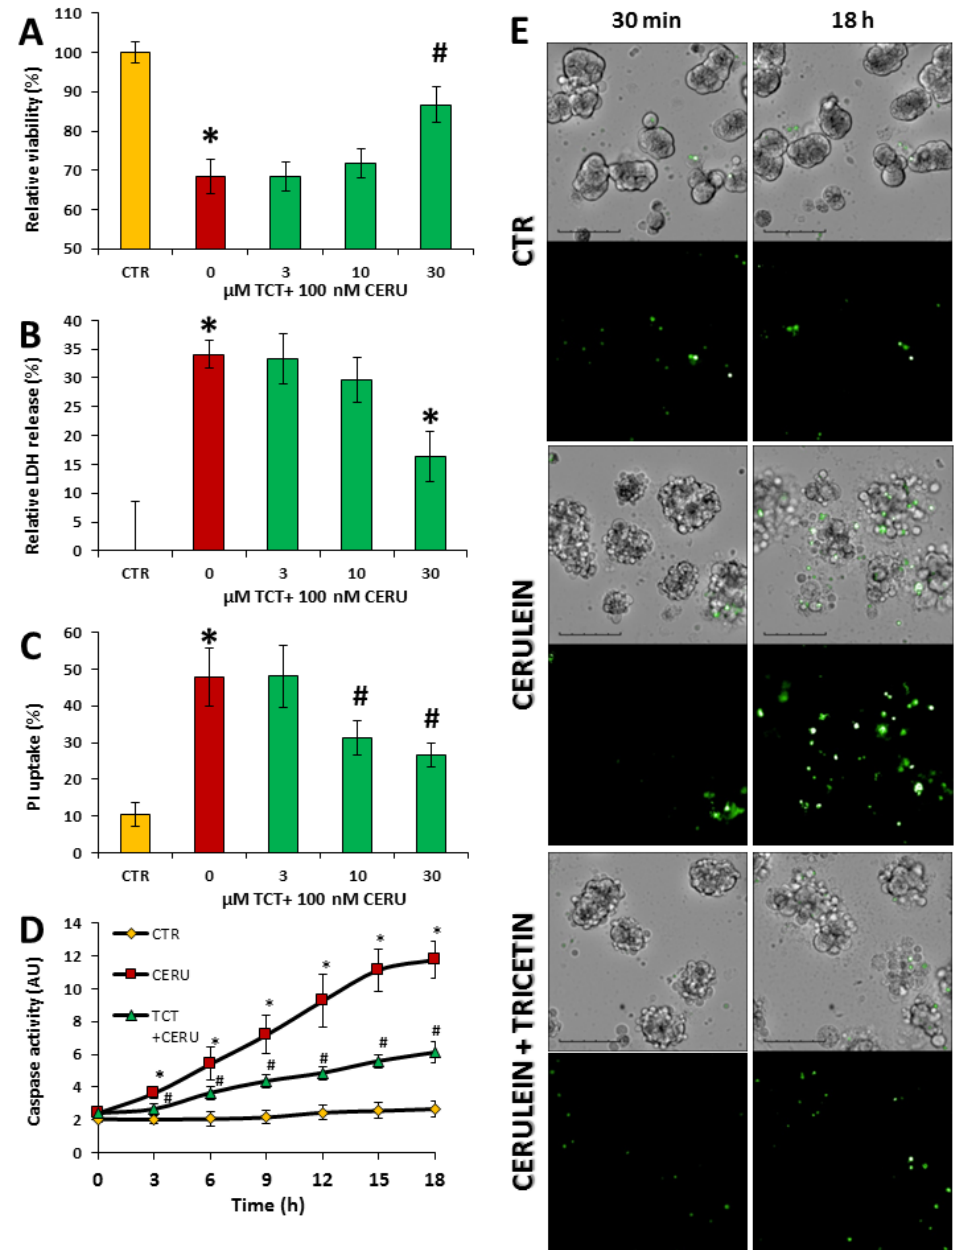
Figure 1. Tricetin protects isolated acinar cells from cerulein-induced cell death. Primary acinar cells were pretreated with 0–30 μ M tricetin (TCT) for 1 h and then treated with 100 nM cerulein for 24 h. Viability was determined with calcein assays ( A ), and necrotic cell death was measured by LDH release ( B ) and propidium iodide (PI) uptake assays ( C ). Primary acinar cells were pretreated with 30 μ M tricetin (TCT) or medium for 1 h and then treated with 100 nM cerulein. Caspase activity was detected every 3 h for 18 h as described in the Materials and Methods section ( D ). Representative images of caspase activity detection at the first and the last time points are shown ( E ). (Scale bar is 100 μ m) Error bars represent the SD of three independent measurements. Statistical analysis was performed with one-way ANOVA test followed by Tukey’s post hoc test. Stars (*) indicate significant ( p < 0.05) difference between cerulein-treated cells versus control. Hashtags (#) indicate significant ( p < 0.05) cytoprotection by TCT versus the cerulein-treated group. This effect was also observed in the LDH release assay (Figure 1B). Pretreatment of the cells with 30 μ M TCT significantly protected acinar cells from cerulein-induced injury in both assays (Figure 1A,B). Necrotic cell death and cell membrane injury are critical